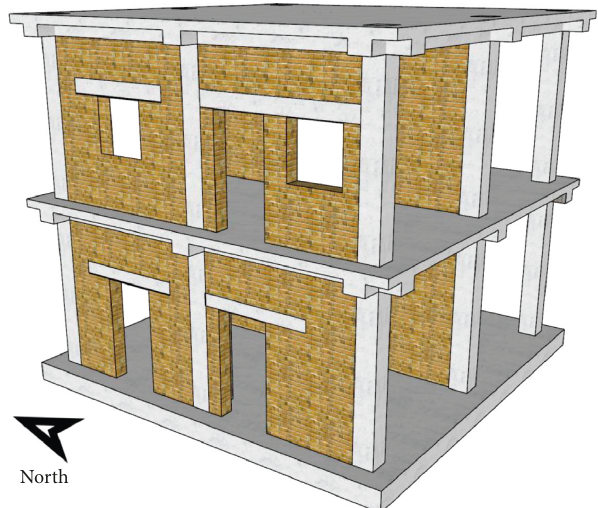
Figure 2: Three-dimensional view of